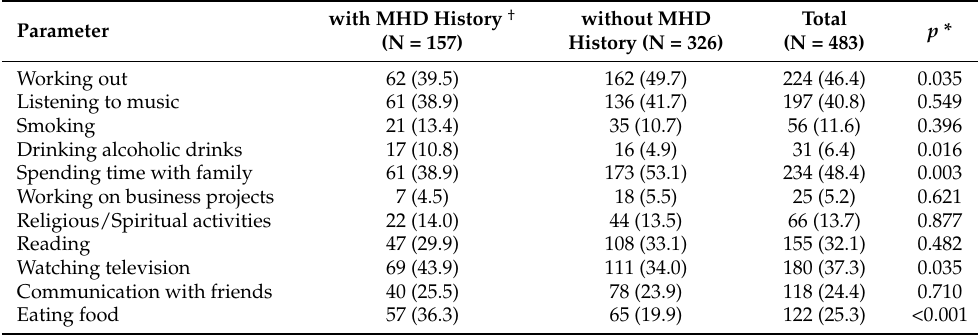
Table 3. Coping mechanisms for stress relief according to the history of mental health disorders in study population (N = 483).